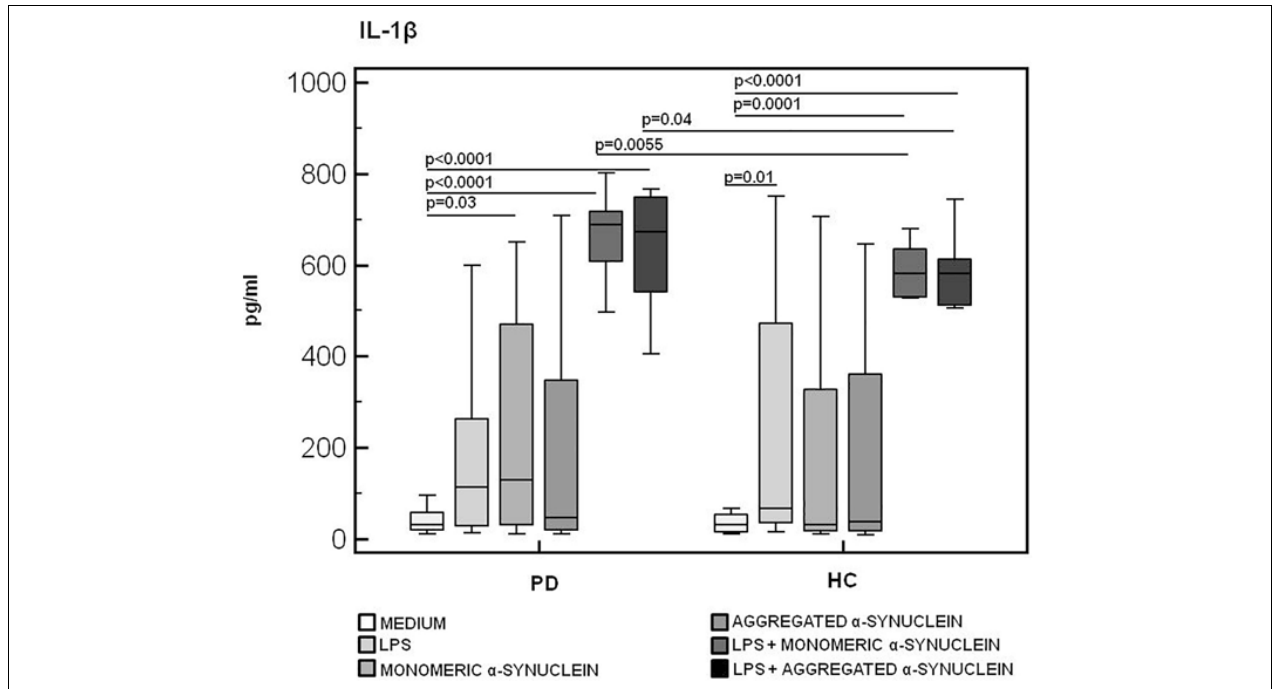
FIGURE 5 | IL-1 β inflammasome effector cytokine production in LPS-primed and monomeric or aggregated α -synuclein–stimulated PBMCs of PD and HC subjects. PBMCs of 15 Parkinson disease (PD) patients and 15 healthy controls (HC) were stimulated as follows: unstimulated, LPS-stimulated, monomeric α -synuclein–stimulated, aggregated α -synuclein–stimulated, LPS-primed and monomeric α -synuclein–stimulated, or LPS-primed and aggregated α -synuclein–stimulated. IL-1 β was quantified in supernatants by enzyme-linked immunosorbent assay. Summary results are shown in the bar graphs. The boxes stretch from the 25th to the 75th percentile; the line across the boxes indicates the median values; the lines stretching from the boxes indicate extreme values.